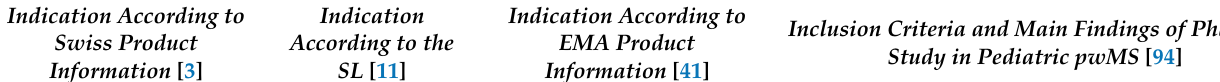
Table 14. Teriflunomide (Aubagio ®